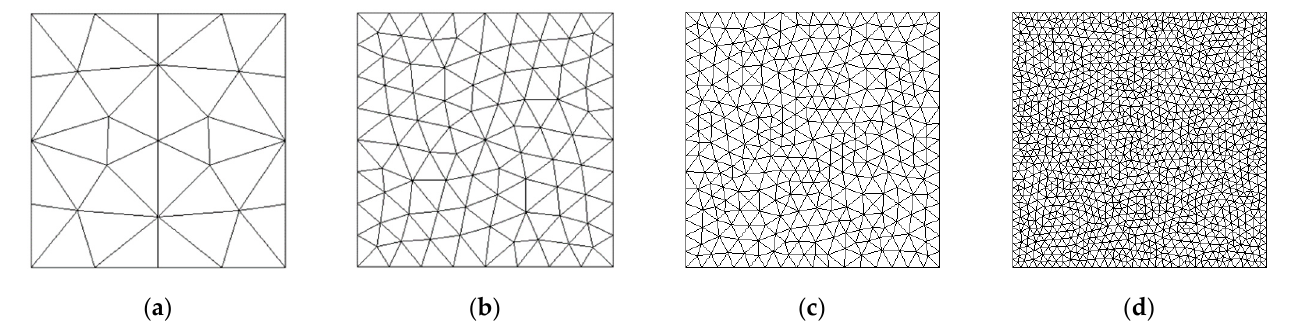
Figure 11. Unstructured finite element meshes: ( a ) mesh U1 with 36 FE; ( b ) mesh U2 with 160 FE; ( c ) mesh U3 with 608 FE; ( d ) mesh U4 with 2268 FE.